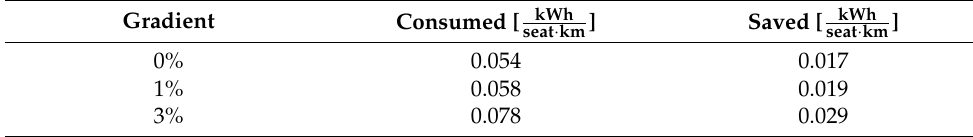
Table 5. Energy per seat per kilometer. Top speed 18.25 m/s.